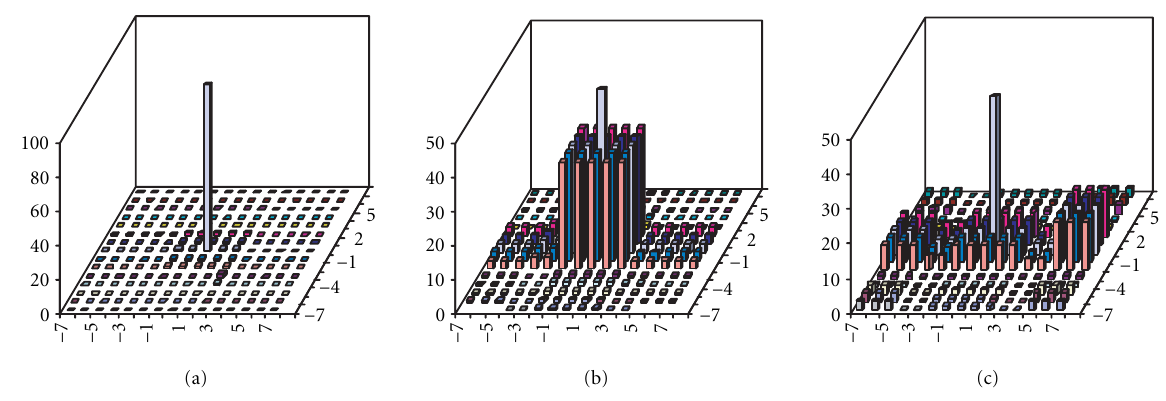
Figure 1: Motion vector distribution for (a) News 0, (b) News 1, and (c) Rallycross